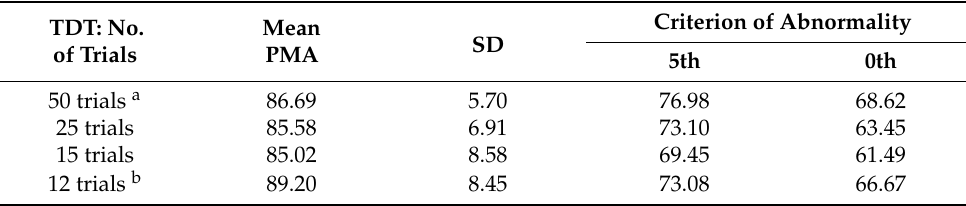
Table 3. Descriptive statistics, criterion of abnormality, and zone of uncertainty from combined dominant and non-dominant hands of the pooled data samples of neurologically healthy older adults for different trial versions of the TDT.